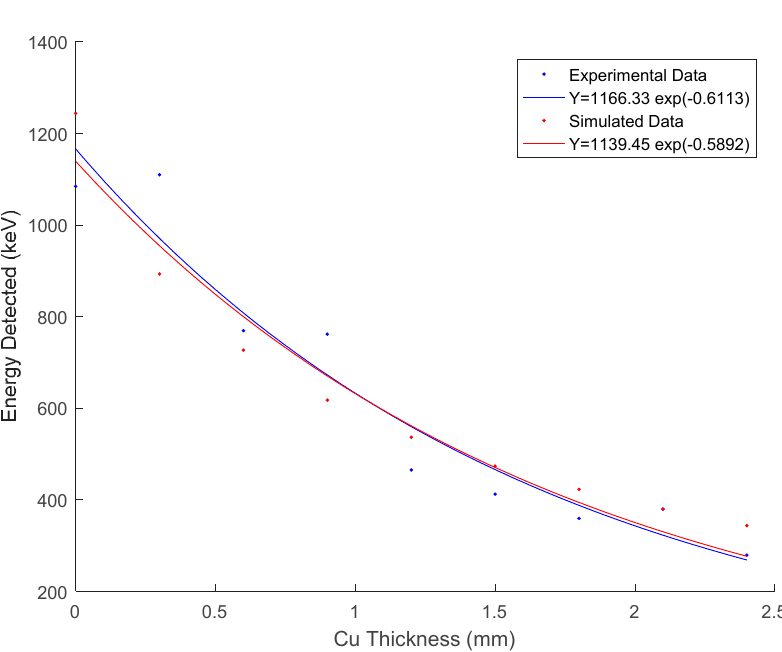
Figure 10. Simulated vs. experimental results for an exponential photon distribution with E mean = 39.5 keV and k [ exp ] = 47.5. The above values are chosen in such a way to obtain the best possible match between the experimental and simulated results. Both curves for experimental and